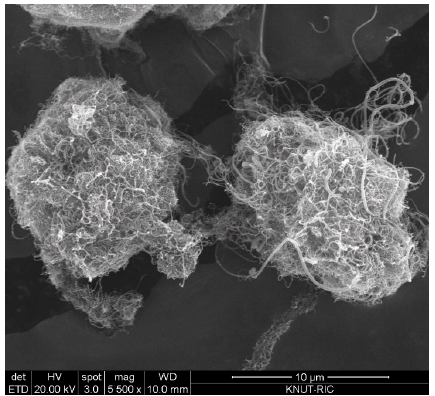
Figure 1. SEM image of vertically aligned carbon nanotube (VACNT) used in experiments.